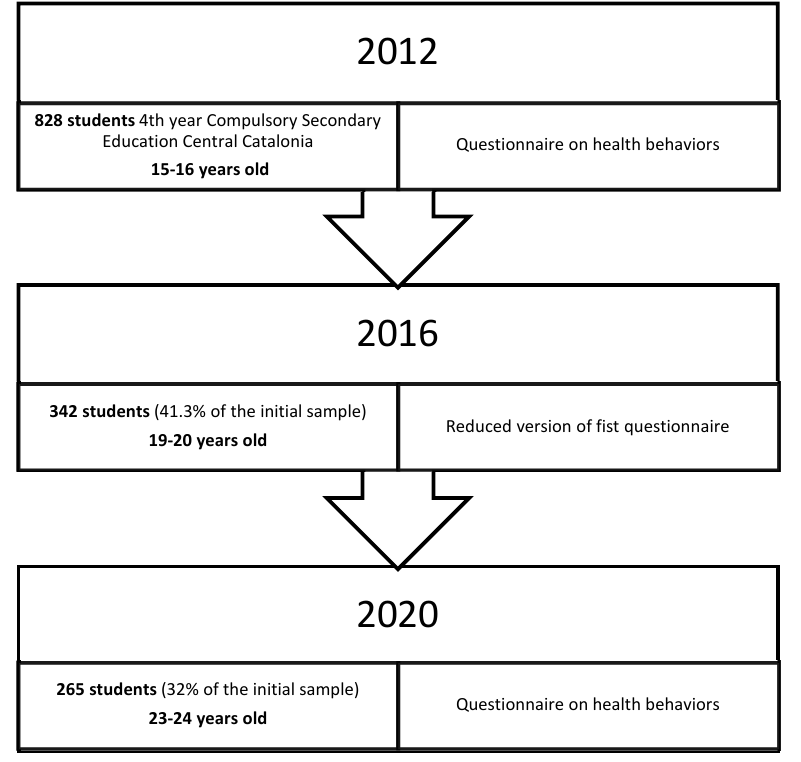
Figure 1. General outline of the study.